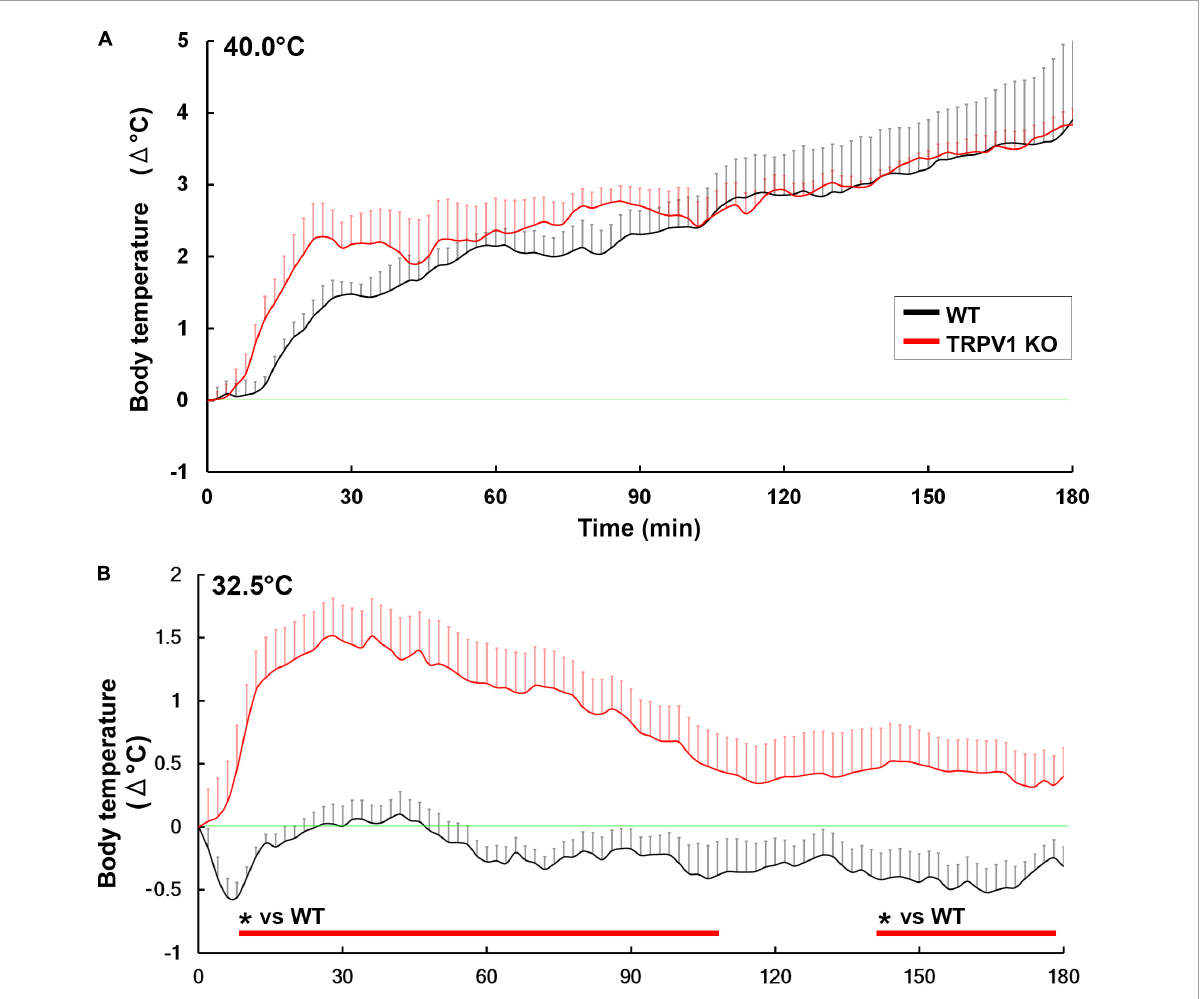
FIGURE8 Abnormal hyperthermia in TRPV1 KO mice upon exposure to moderately warm ambient temperature. Both WT and TRPV1 KO mice showed similar increases in core body temperature upon exposure to 40 ◦ C (A) . Upon exposure to 32.5 ◦ C, TRPV1 KO mice exhibited hyperthermia, but hyperthermia was not seen in WT mice (B) . * p < 0.05 between WT and TRPV1 KO mice with unpaired Student’s t -test. Graphs are rearranged with permission from Springer Nature (Park et al.,